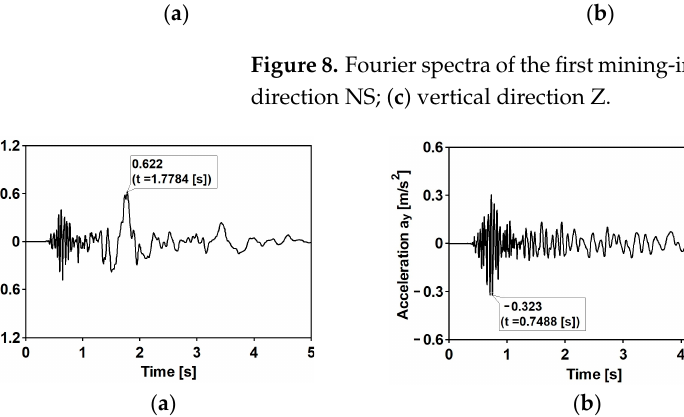
( c ) Figure 10. Fourier spectra of the second mining-induced shock: ( a ) horizontal direction WE; ( b ) hor- izontal direction NS; ( c ) vertical direction Z. 4. Adopted Finite Element Model for Numerical Analyses The finite element (FE) elastic model of the footbridge (Figure 11) was implemented in ABAQUS/Standard [36]. The 8-node and 3-node brick finite elements were used to model concrete elements and transverse steel beams, and the steel beams of the girders were modeled by 3-node shell elements. The total number of elements was about 316,000, and the element dimensions were determined based on the convergence analysis, with the first natural frequency value serving as the convergence criterion. Kinematic coupling constraints are given between the bottom of the girders and the top of the pillars based on the different bearing types applied in the structure. Due to efficiency reasons, non-